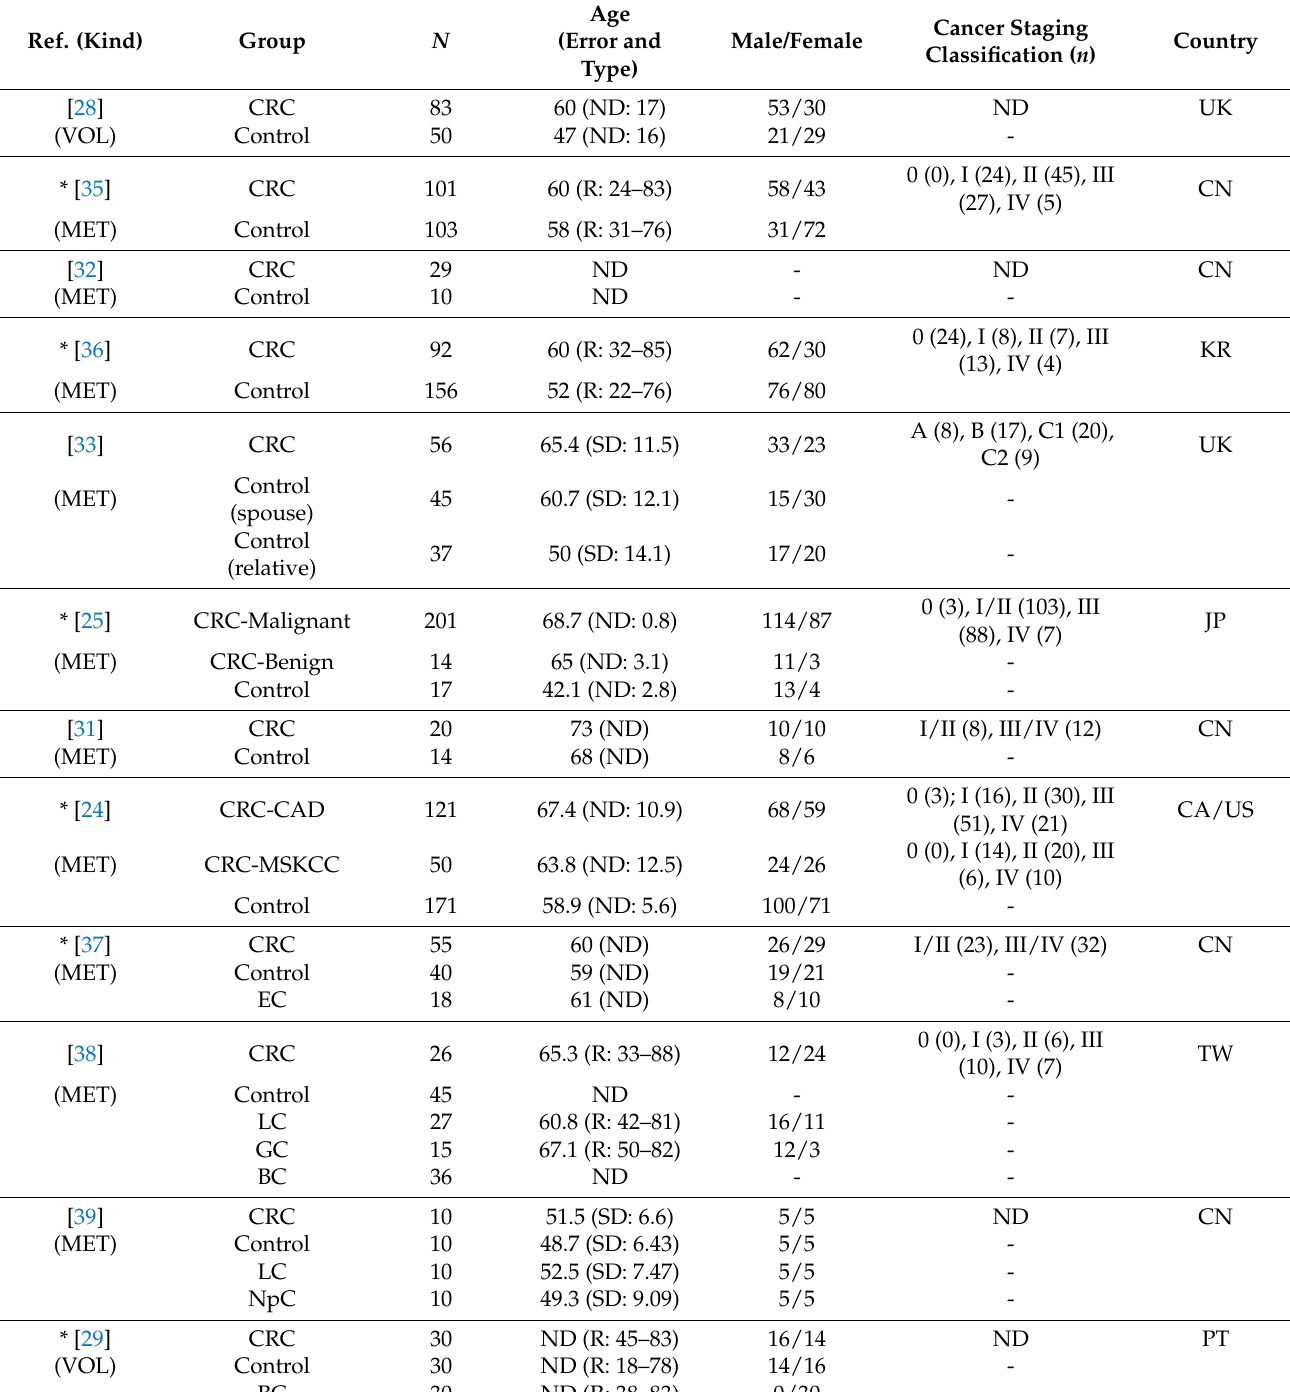
Table 2. Cohort information from the systematic review (qualitative analysis) of selected studies. The asterisk * indicates that the study was used in the meta-analysis (quantitative